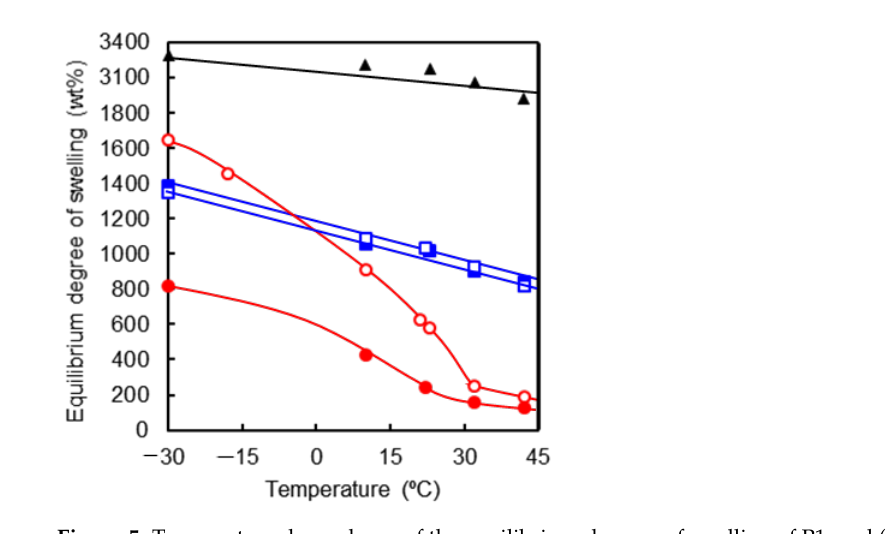
Figure 5. Temperature dependence of the equilibrium degrees of swelling of P1a-gel (red solid circle), P1b-gel (red open circle), P2a-gel (blue solid square), P2b-gel (blue open square), and poly(cyclohexyl methacrylate)-gel (black solid triangle) in chloroform.